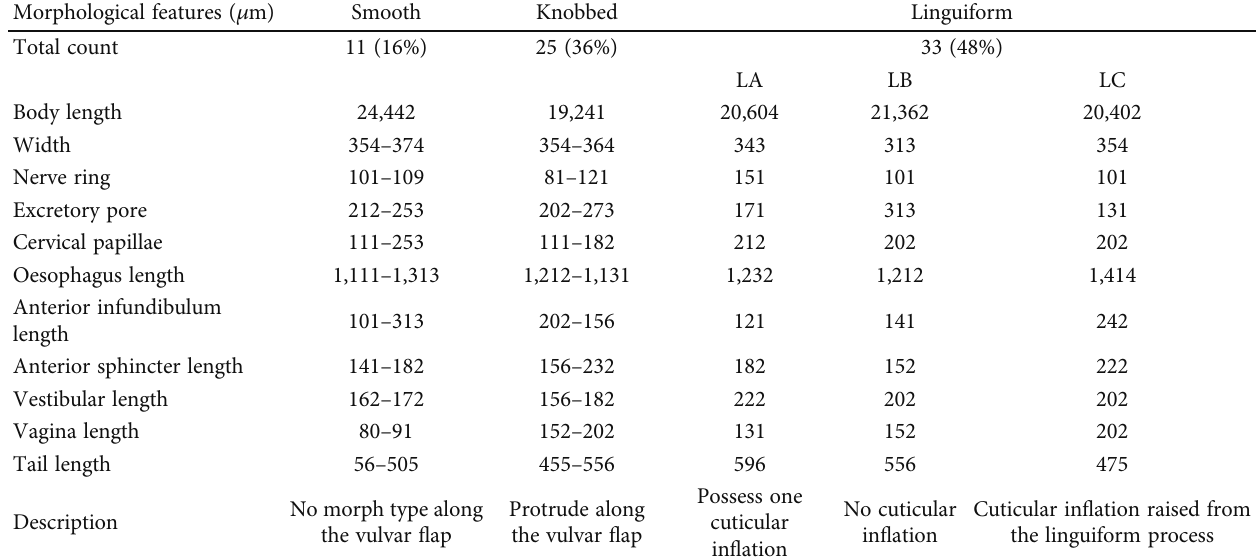
Table 2: Morphometric of female Haemonchus contortus showing vulvar position and accompanied features of smooth, knobbed, and linguiform morphotypes.